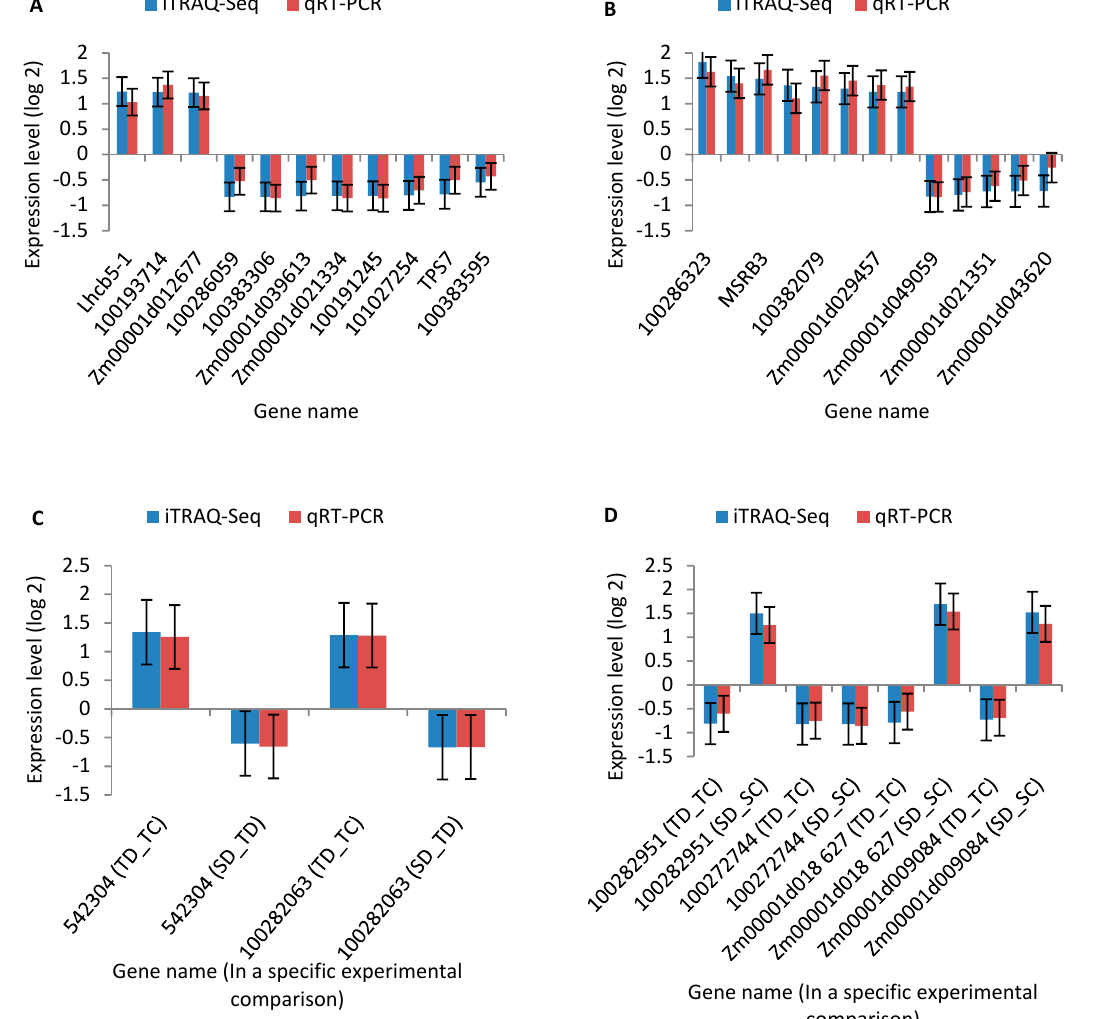
Figure 8. Confirmation of iTRAQ-seq results by quantitative real-time PCR (qRT-PCR). Quantitative RT-PCR analysis of the expression patterns of the maize seedling leaf genes encoded by differentially abundant proteins (DAPs) from different comparisons: ( A ) DAPs specific to TD_TC; ( B ) DAPs specific to SD_TD; ( C ) DAPs shared between TD_TC and SD_TD; and ( D ) Common DAPs shared between TD_TC and SD_SC. The y -axis represents qPCR relative expression levels (log 2 -fold change) and fold-change of the iTRAQ-seq data. All genes with negative values of expression level means that they were down-regulated in response to drought stress. Maize gene GAPDH (accession no. X07156) was used as the internal reference. Error bars represent the SE ( n = 3).